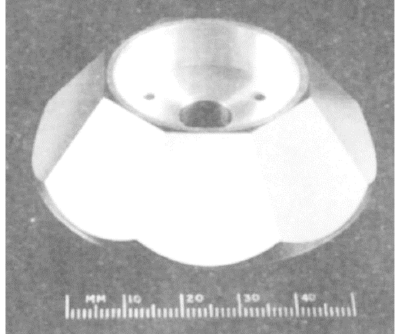
Figure 4. RSRE-coated polygon for a coaxial scanner